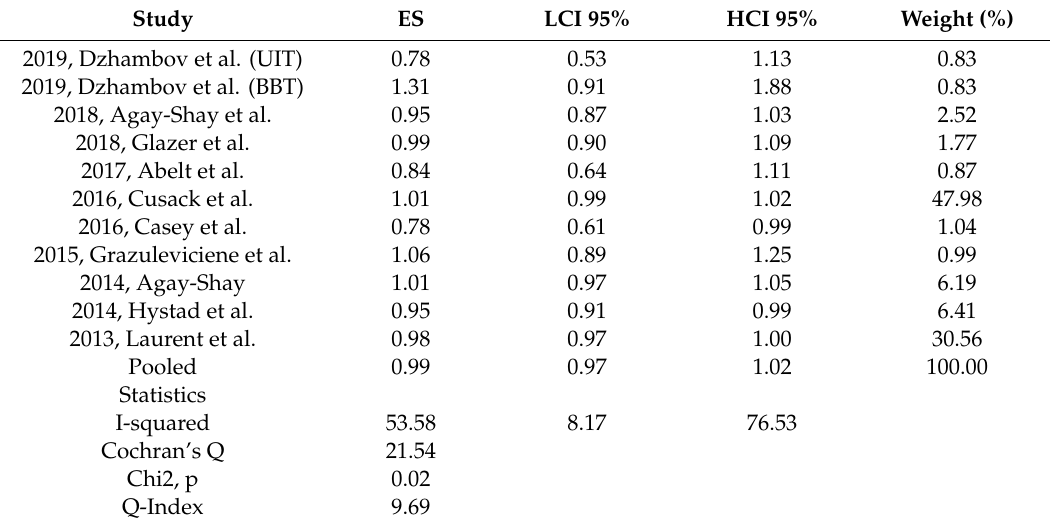
Table 4. Meta-Analysis Results for the effect of NDVI increase on preterm birth (odds ratios, quality